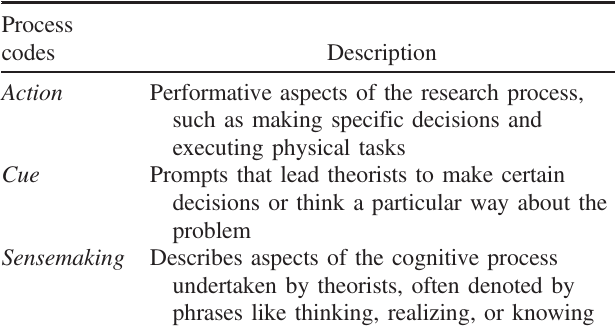
TABLE I. Short descriptions of the process codes that were used during the first phase of